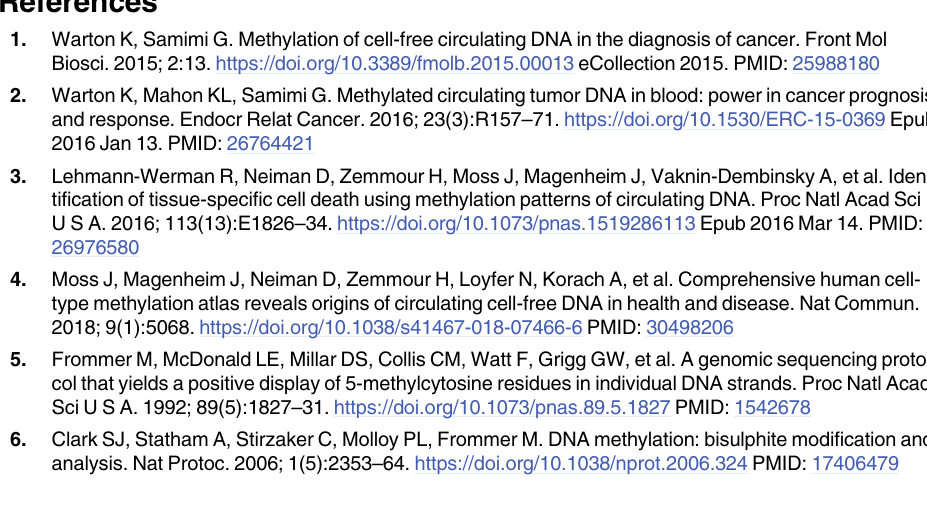
S1 Fig. Quantitation of ssDNA on agarose gel during electrophoresis timecourse. Agarose gel ratio of control to bisulphite treated PCR product band intensity after 15 minutes and 40 minutes of electrophoresis for (A) SNAI1 and (B) IDH1. S2 Fig. Raw